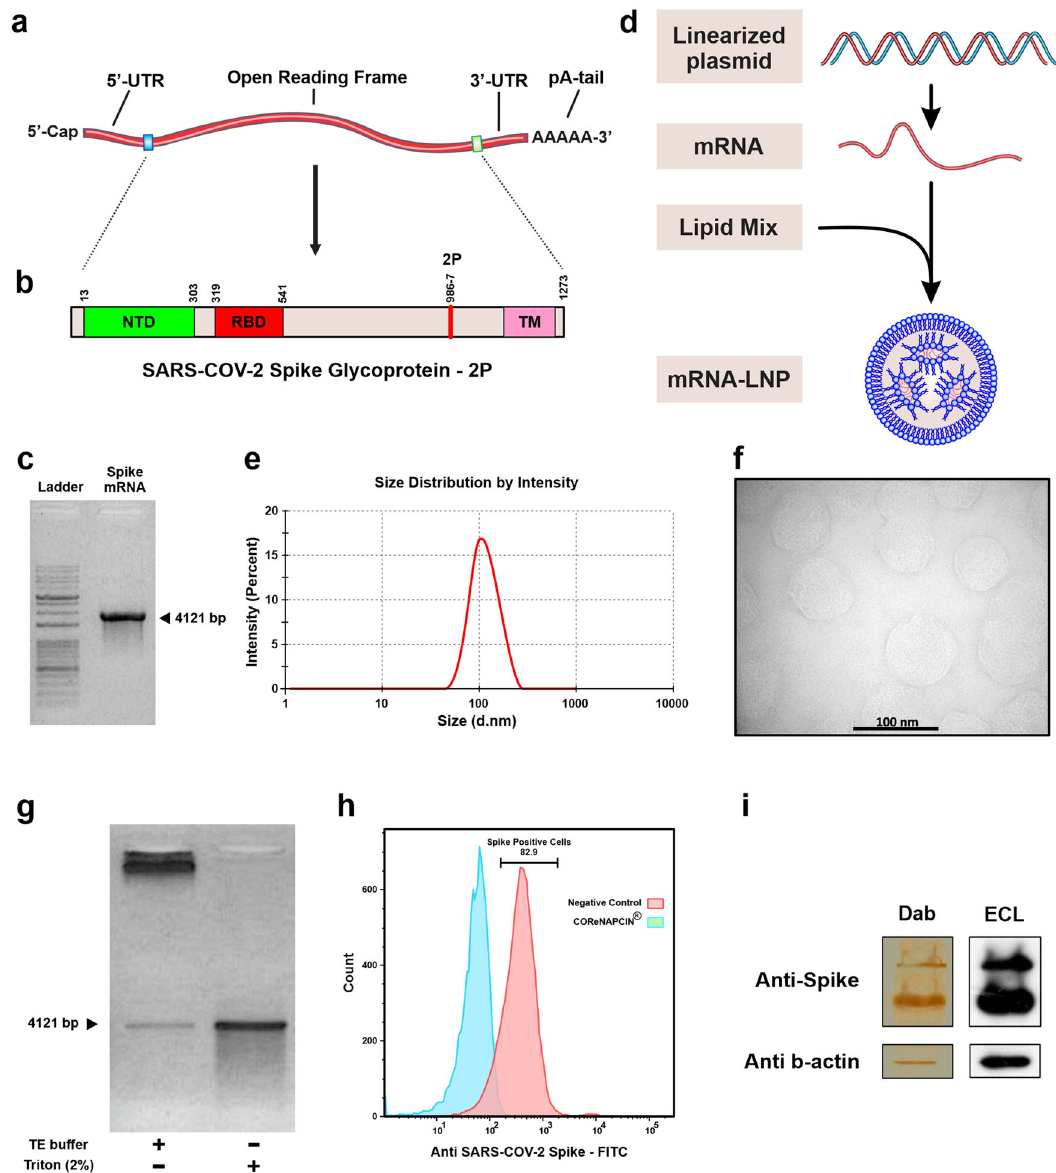
Fig. 1 Brief representation of COReNAPCIN ® design, production, and evaluation. a Structure of COReNAPCIN ® mRNA. b Structure of COReNAPCIN ® mRNA encoded SARS-CoV-2 Spike glycoprotein-2P. The 2 P abbreviation indicates substitution of native amino acids with two proline residues at positions 986 and 987 to produce the pre-fusion stabilized form of the Spike glycoprotein for better antigenic representation at the cell surface. c Evaluation of the purity and integrity of the produced COReNAPCIN ® mRNA with gel electrophoresis. d Schematic representation of COReNAPCIN ® production procedure. The COReNAPCIN ® mRNA is made by in-vitro transcription (IVT) from the linearized plasmid DNA template, then is mixed with special lipid components to form the fi nal COReNAPCIN ® mRNA-LNP drug product. e Evaluation of the size distribution of COReNAPCIN ® mRNA-LNPs with Dynamic Light Scattering (DLS). f Evaluation of the COReNAPCIN ® particles by Transmission Electron Microscopy (TEM). g Evaluation of mRNA encapsulation ef fi ciency by Gel Retardation Assay. h Evaluation of the expression of SARS-CoV-2 Spike glycoprotein-2P at the cell surface by fl ow cytometry. i Evaluation of SARS-CoV-2 Spike glycoprotein-2P expression by Western